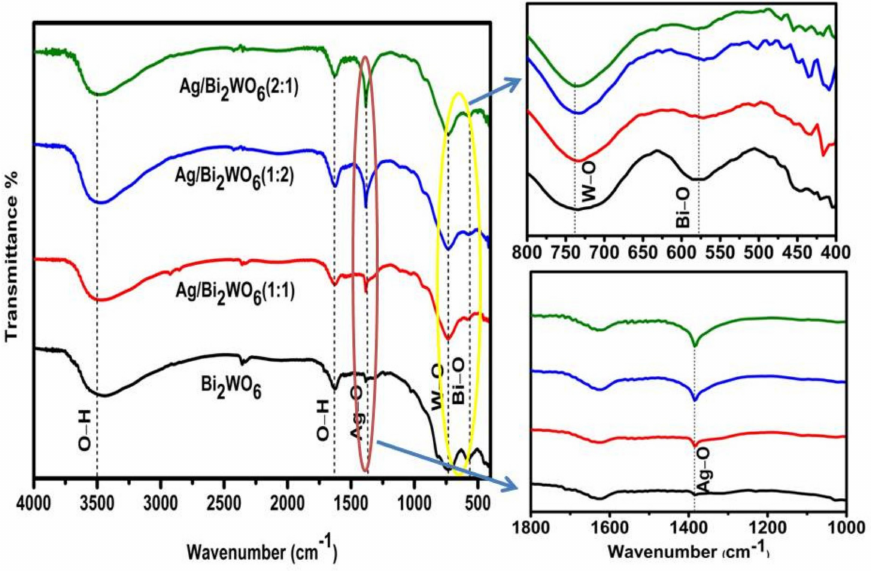
Figure 4. FTIR spectra of pure Bi 2 WO 6 and Ag/Bi 2 WO 6 (1:1, 1:2 and